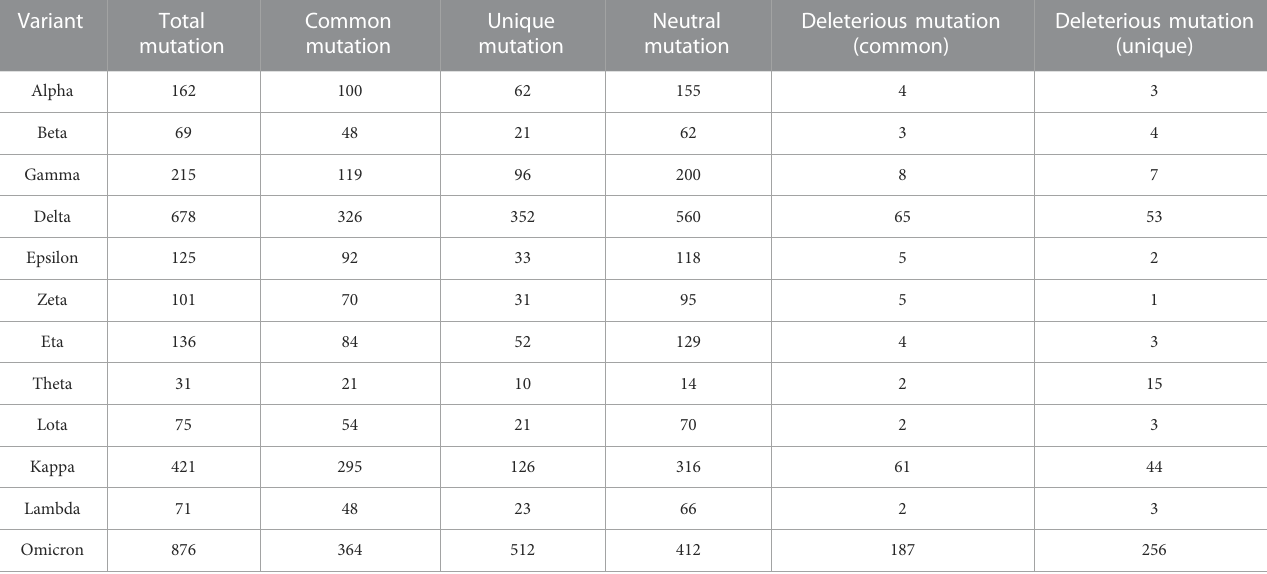
TABLE 2 Comparison of mutations in the spike protein among 12variants of SARS-CoV-2.